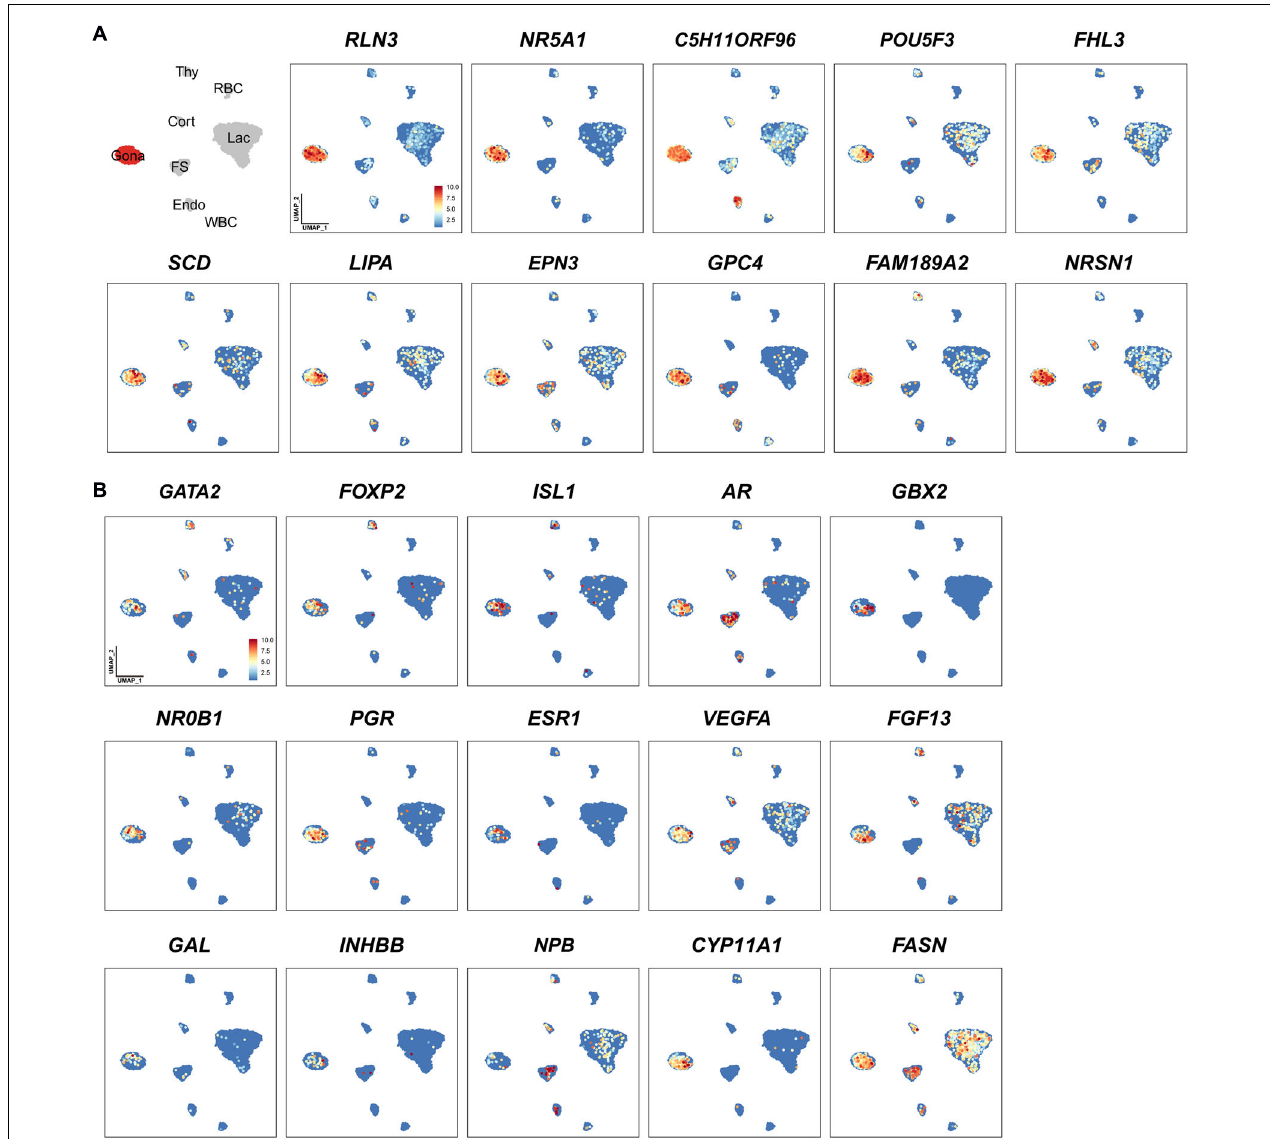
FIGURE 3 | Uniform Manifold Approximation and Projection (UMAP) maps showing the expression of some genes expressed in gonadotrophs of chicken anterior pituitaries. (A) The selected marker genes in pituitary gonadotrophs. (B) UMAP maps showing the expression of some non-marker genes, including transcription factors ( GATA2 , FOXP2 , ISL1 , AR , GBX2 , NR0B1 , PGR , ESR1 ), growth factor/peptide ( VEGFA , FGF13 , GAL , activin B (encoded by INHBB ), and NPB ), and enzymes ( CYP11A1 , FASN ) in pituitary gonadotrophs. Color bar indicates the relative expression level of each marker gene from the lowest (light blue dots) to the highest expression level (dark red